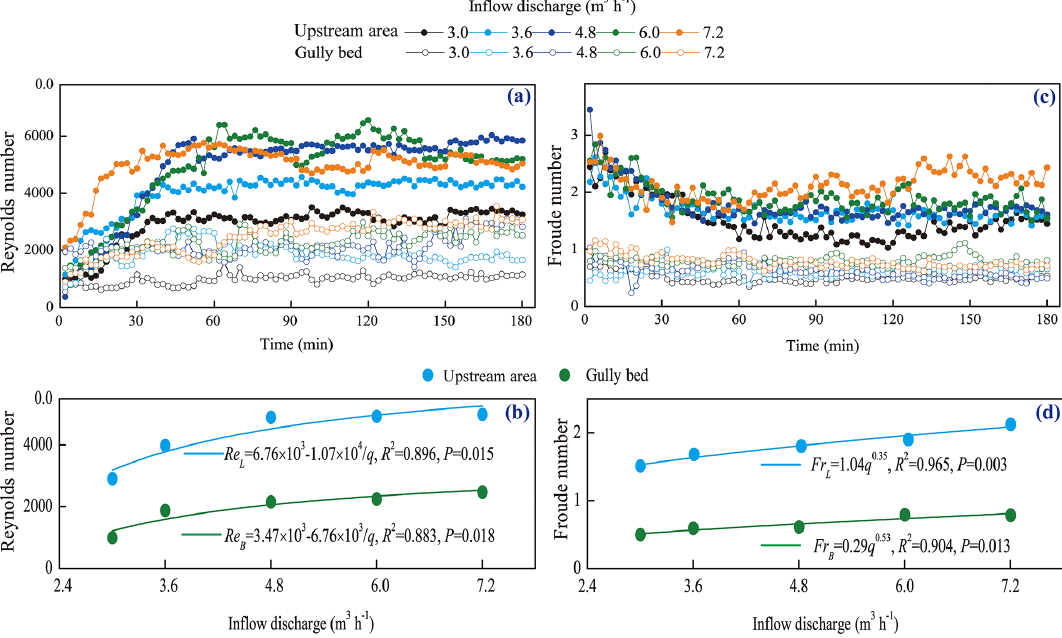
Figure 5. Temporal changes in the runoff regime of the upstream area and gully bed and their relationships with inflow discharge.